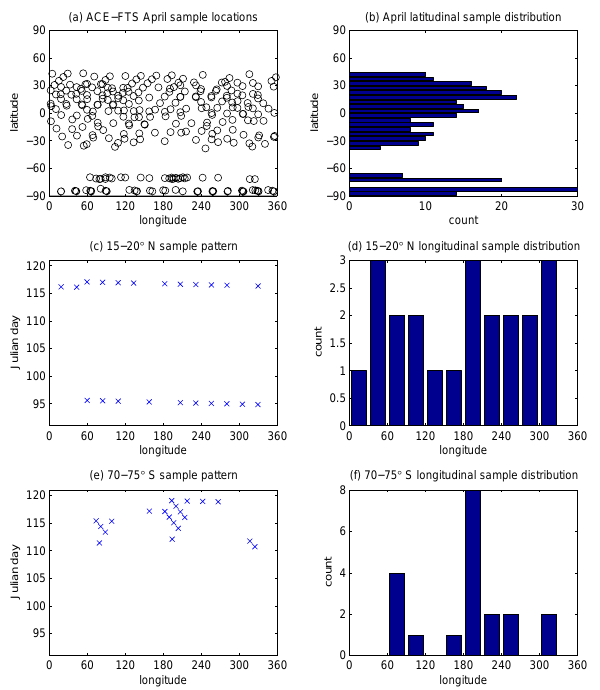
Fig. 4. ACE-FTS sampling from April 2005. (a) Full monthly sam- pling spatial pattern, (b) monthly sample counts per 5 ◦ latitude bin, (c) time, longitude pattern of samples and (d) zonal sample distri- bution for the 15–20 ◦ N latitude bin, (e) time, longitude pattern of samples and (f) zonal sample distribution for the 70–75 ◦ S latitude bin.